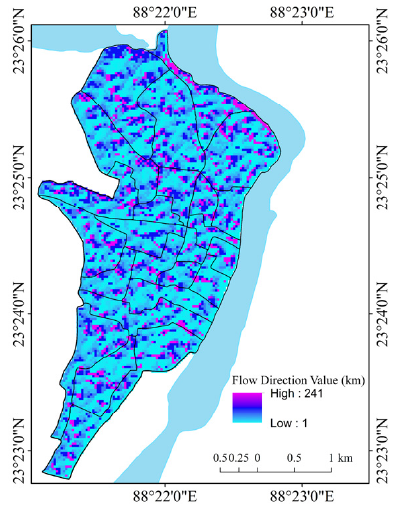
Figure 16. Flow direction (2000).